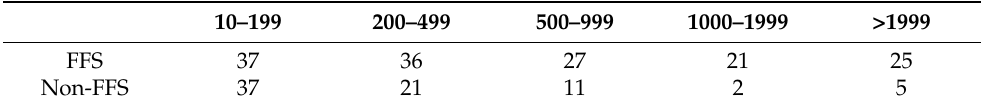
Table 1. Sample distribution among different herd sizes between Farmer Field Schools (FFS) and non-FFS